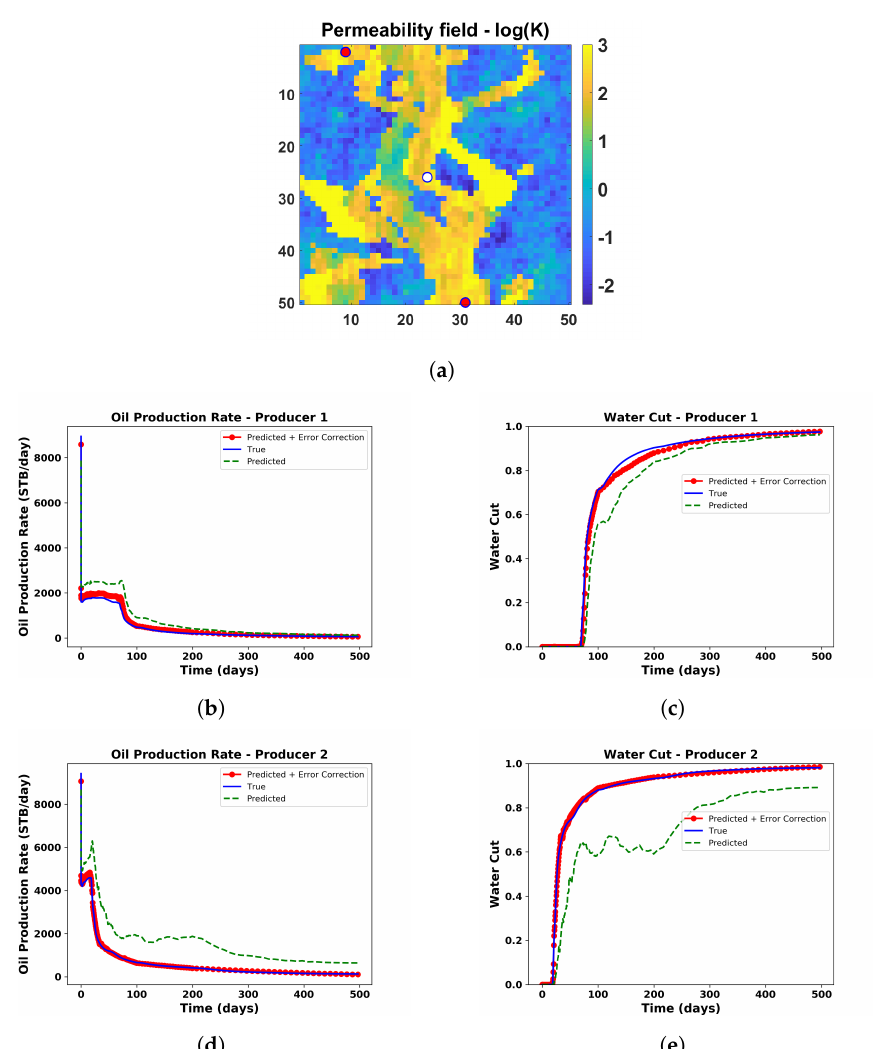
Figure 50. ( a ) Test case 1 with producer 1 at (9,2) and producer 2 at (31,50). ( b ) Comparison of oil production rate for producer 1, ( c ) comparison of water cut for producer 1, ( d ) comparison of oil production rate for producer 2, and ( e ) comparison of water cut for producer 2, predicted using the global PMOR method alone (dotted green line) and after the implementation of the error correction model (red circled line) with the true solution (blue line).